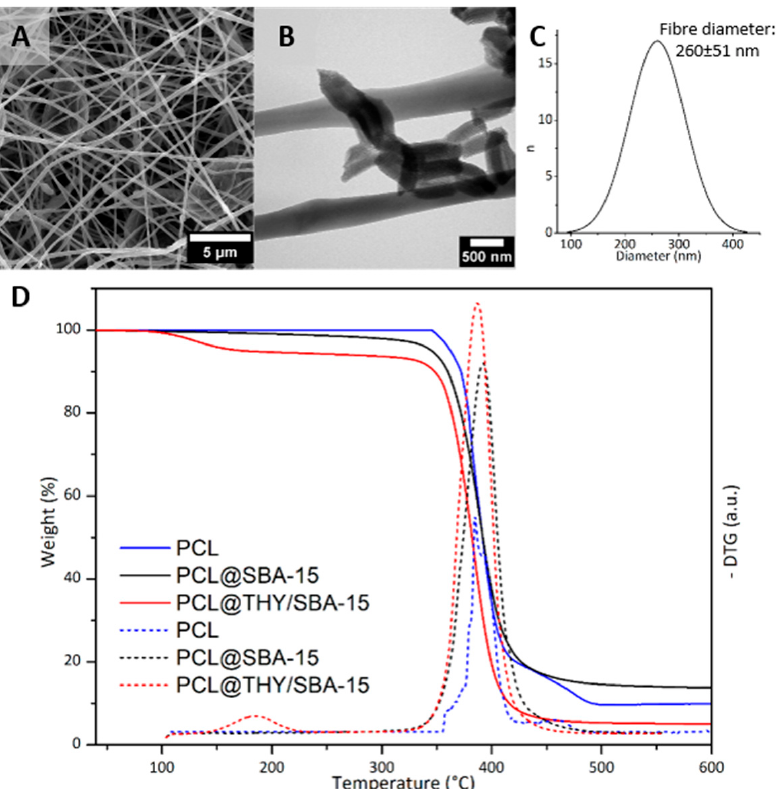
Figure 3. ( A ) SEM and ( B ) TEM images of PCL@THY / SBA-15 fibers; ( C ) fibers diameter histogram; ( D ) TGA curves of fibers containing loaded and un-loaded Figure 3. A ) SEM and B ) TEM images of PCL@THY/SBA-15 fibers; C ) fibers diameter histogram; D ) TGA curves of fibers containing loaded and un-loaded particles.